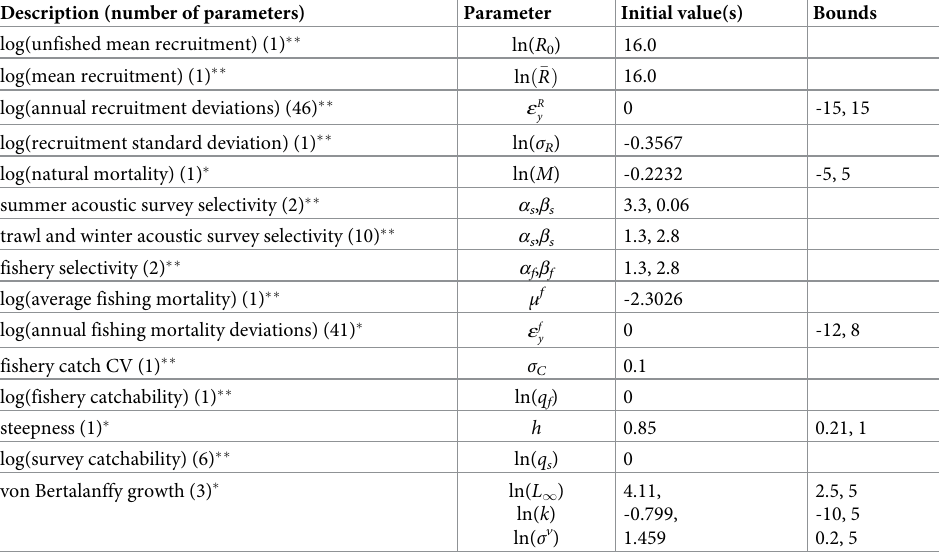
(cid:3) These initial values are from application of the Generalized Yield Model to krill model (values obtained from CCAMLR Secretariat), or recommended by a panel from the Center for Independent Experts that reviewed our integrated krill model in 2016, except the von Bertalanffy variability of length with age (ln( σ v )), which was based on early model runs. (cid:3)(cid:3) These initial values are based on fitting the data in early model